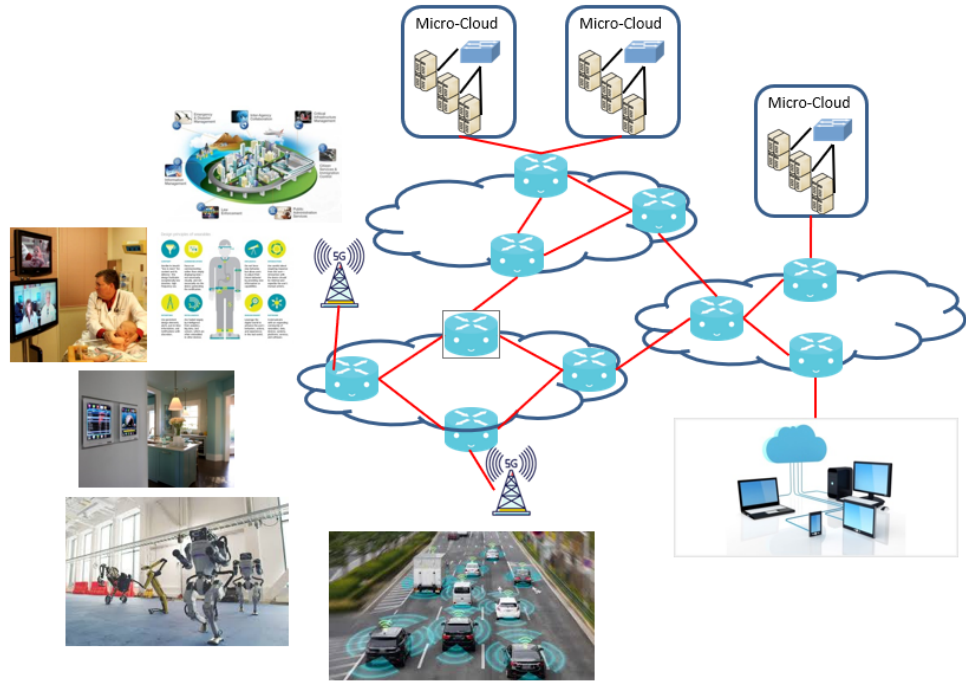
Figure 1. Internet of Things on 5G multiple-access edge computing